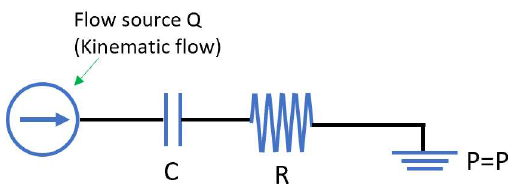
Figure 19: Circuit for the kinematic solution. Figure 19. Circuit for the displacement